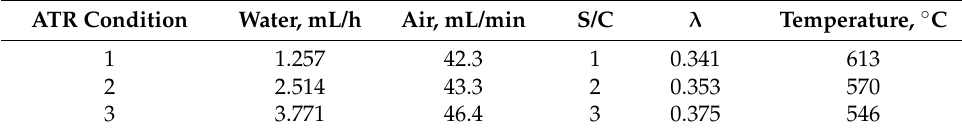
Table 4. Flows for ATR using R-M and RC-M monoliths (HAc 2 mL/h).